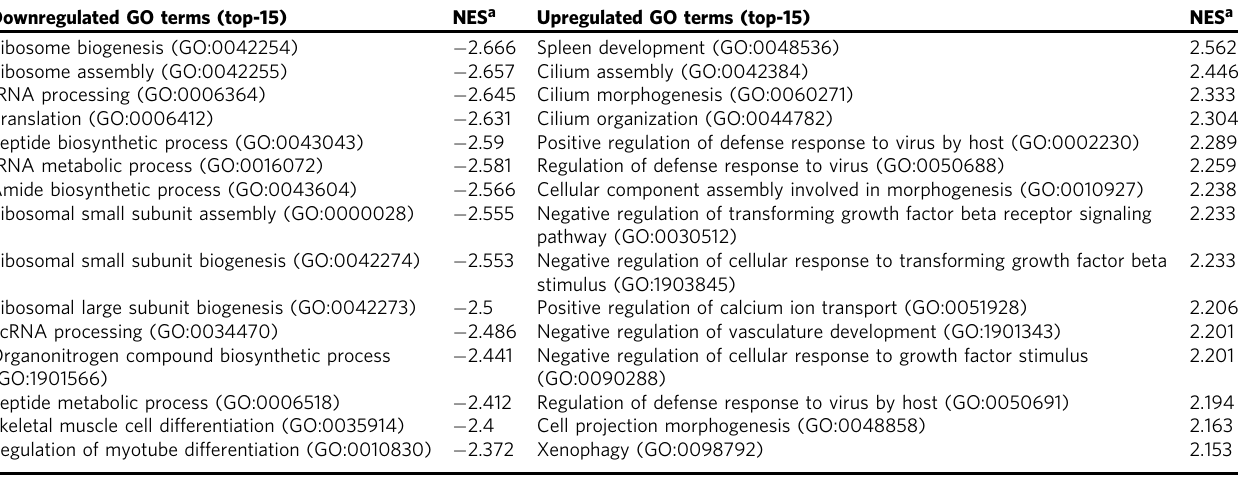
Table 1 Top-enriched Gene ontology terms using GSEA for 3505 DEGs for H3mm7 − / − vs. H3mm7 + / + C2C12 cells Downregulated GO terms (top-15) NES